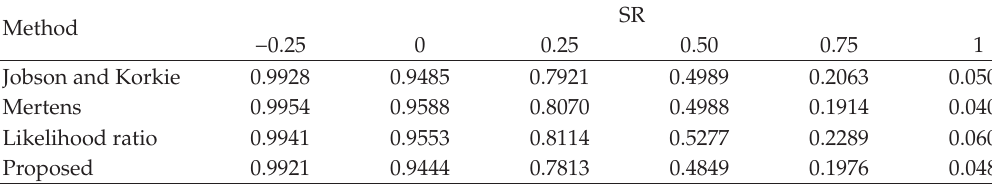
Table 4: Market: p values for